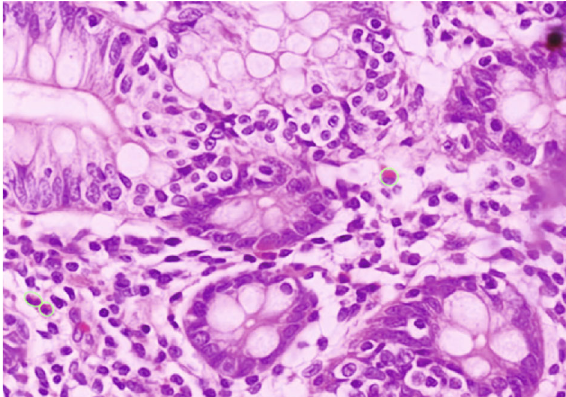
Figure 5: High power view of the mucosa of the ascending colon at a site distant from the tumour showing eosinophils outlined in fl uorescent green; numbering < 5 per